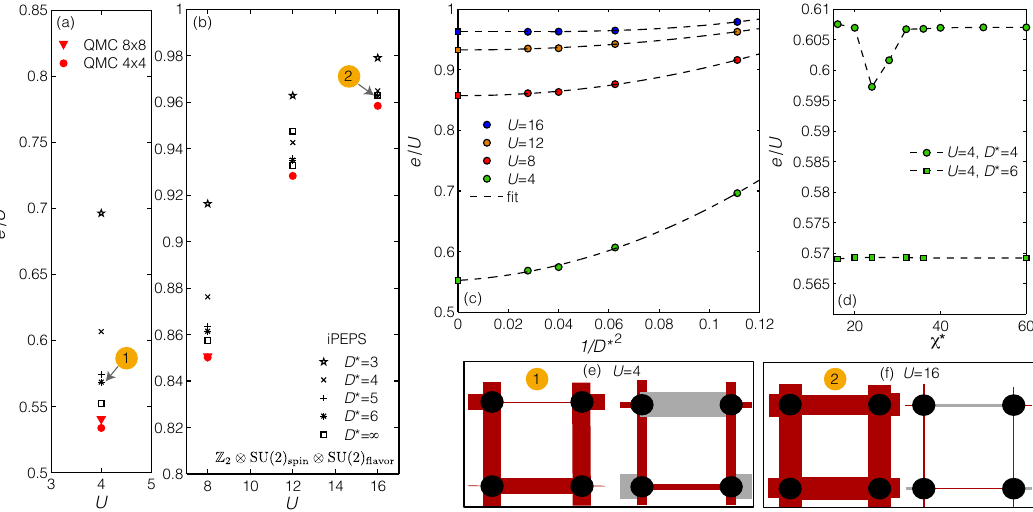
Figure 8: Non-abelian iPEPS results for the two-band Hubbard model with a 2 × 2 unit cell using simple update at half-filling 〈 n 〉 = 2. Panels (a) and (b) display the nor- / U as a function of U from iPEPS for various malized ground-state energy per site e 0 multiplet bond dimensions D ∗ (black symbols) in comparison to QMC data (red sym- bols). The iPEPS energies were obtained by extrapolation vs. 1 / D ∗ 2 → 0 (squares), with the extrapolations shown in (c). The convergence of the energy with the envi- ronmental bond dimension χ ∗ is shown in (d), where the maximum χ ∗ = 60 roughly corresponds to χ = 200. Labels (1) and (2) in panels (a) and (b) point to individ- ual iPEPS wavefunctions characterized in panels (e) and (f). There the diameter of the black dots is proportional to the average local occupation, and the bond width [ Eq. (81b) ] . To better illustrate the breaking of translational to the bond energy e ij 0 invariance in the unit cell, the right subpanels in (e) and (f) depict the same wave- → e ij − ( e / 2 ) . functions, but with bond energies shifted relative to their mean, e ij 0 0 0 Here red (gray) bond correspond to positive (negative) values,